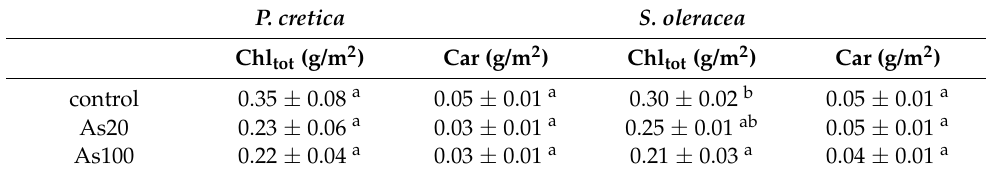
Table 3. Effect of As treatments on photosynthetic pigments in Pteris cretica and Spinacia oleracea shoots. Values represent the mean ± SE of three biological and three technical replicates per sample. Data with the same letter are not significantly different. Different letters indicate significant differ- ences ( p ≤ 0.05) among treatments according to the Kruskal-Wallis test. Abbreviations: control—0 mg As/kg soil; As20—20 mg As/kg soil; As100—100 mg As/kg soil; Chl tot —total content of chlorophylls;